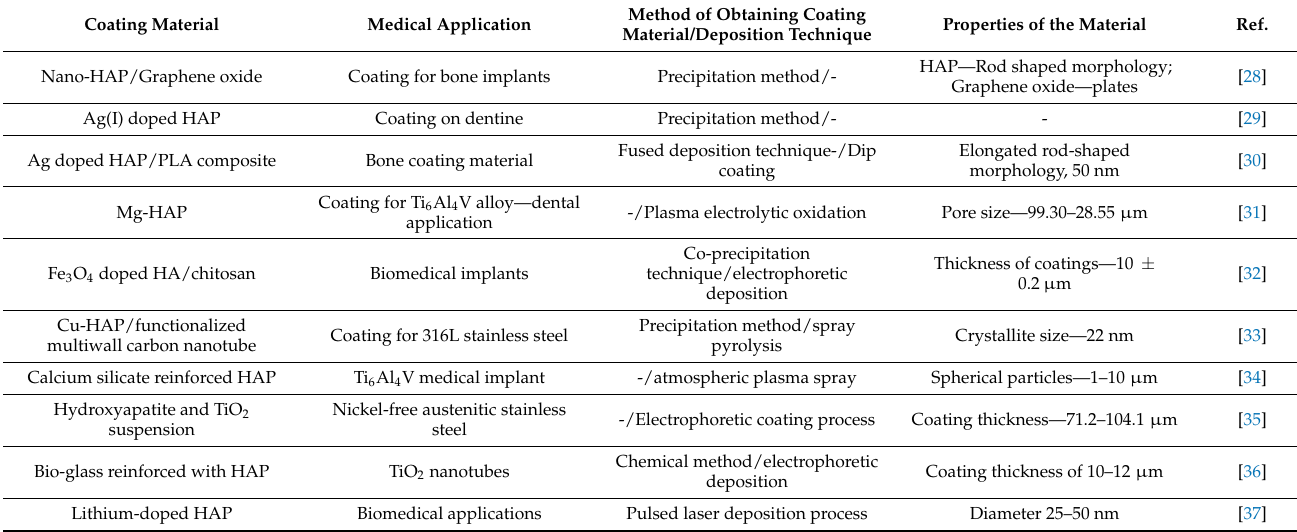
Table 1. Recent advances regarding coating materials for